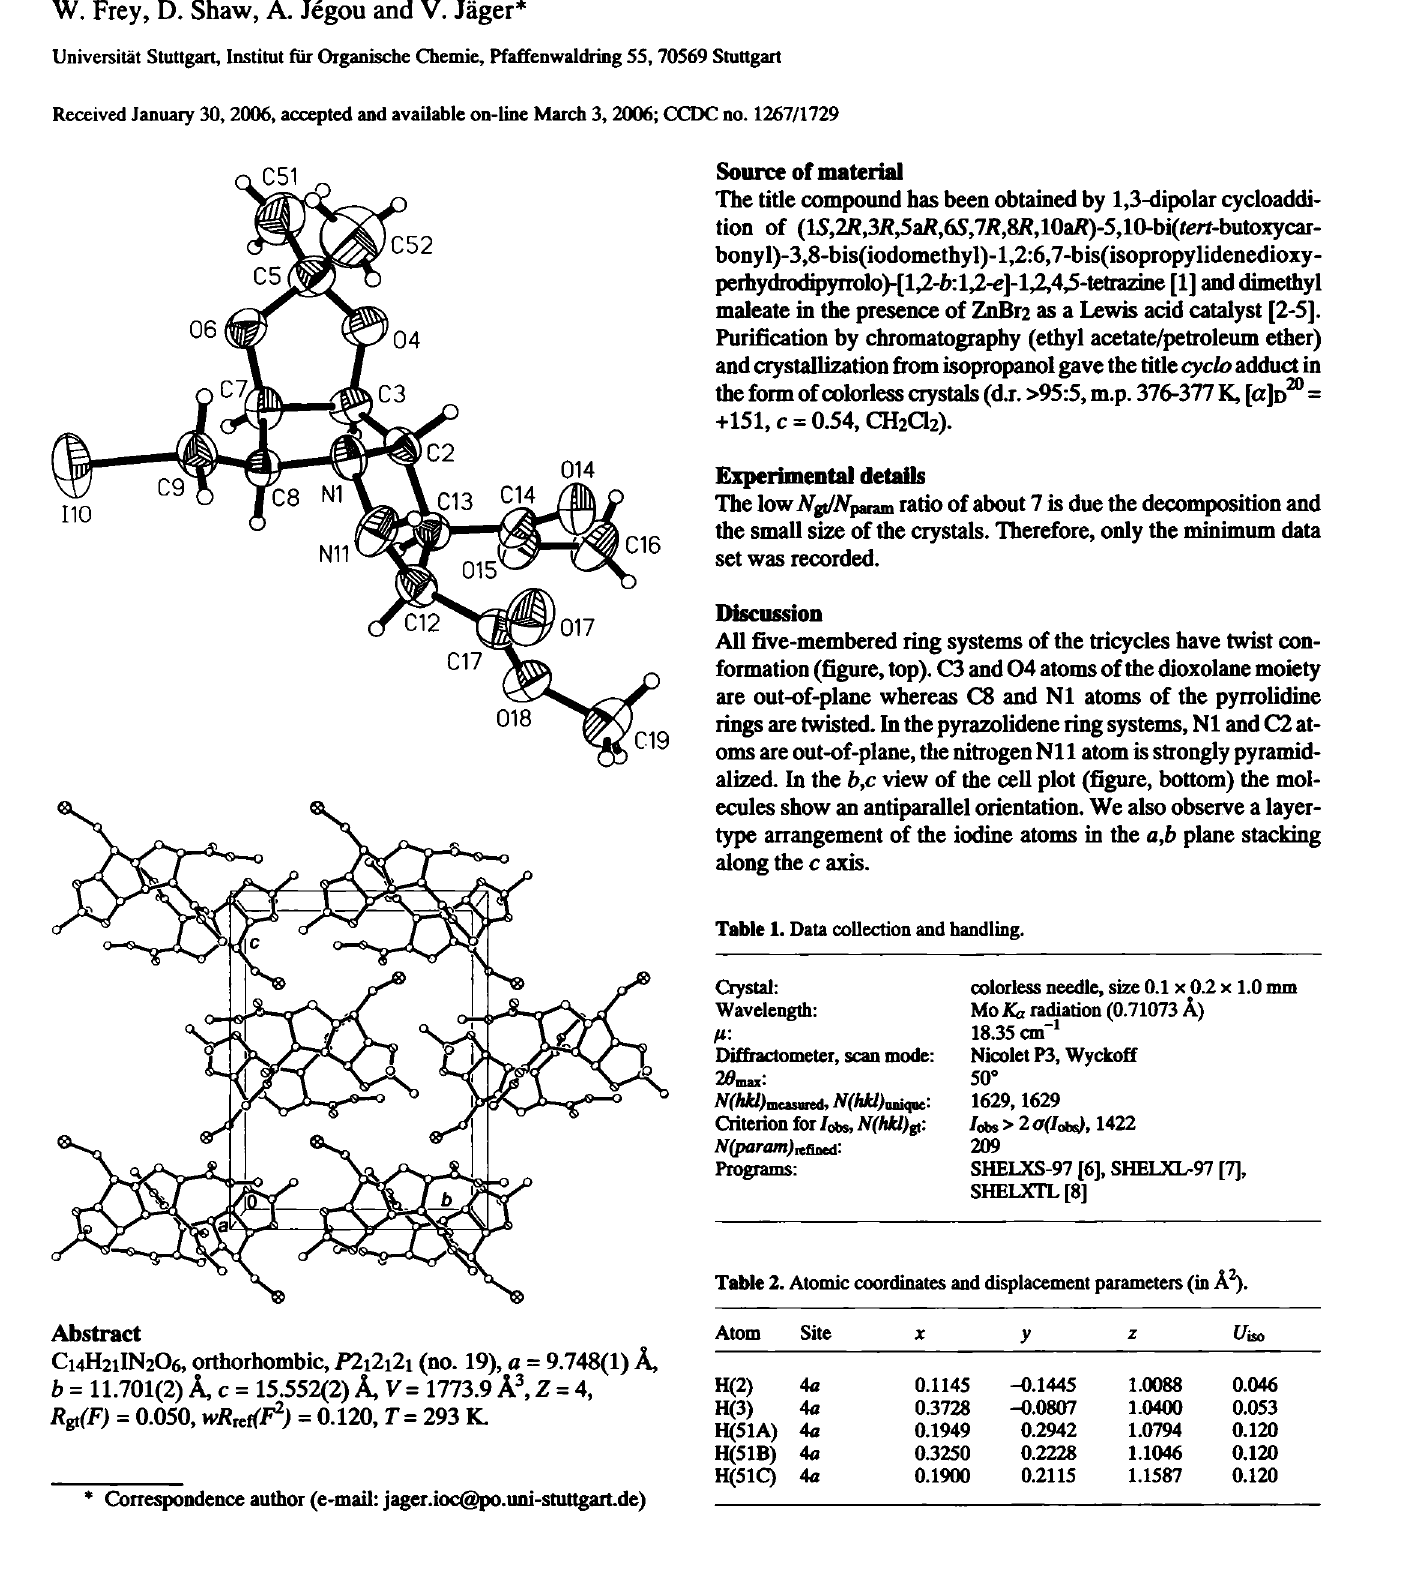
Table 2. Atomic coordinates and displacement parameters (in A 2